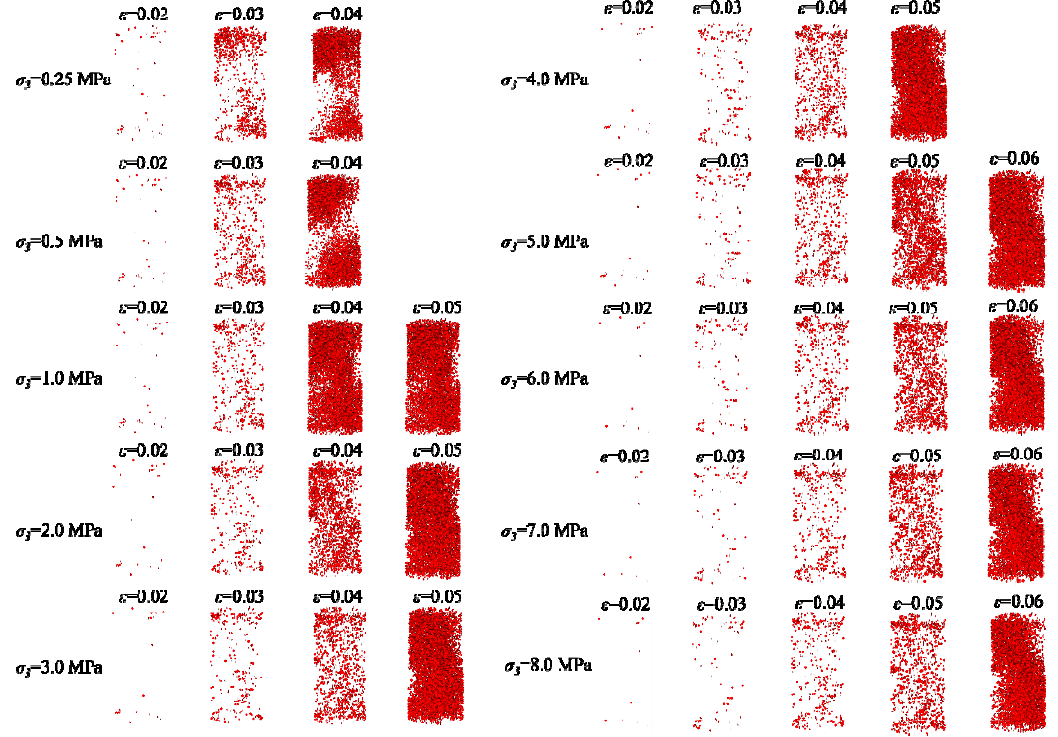
Figure 16. Crack development of coal specimens under different confining stresses.